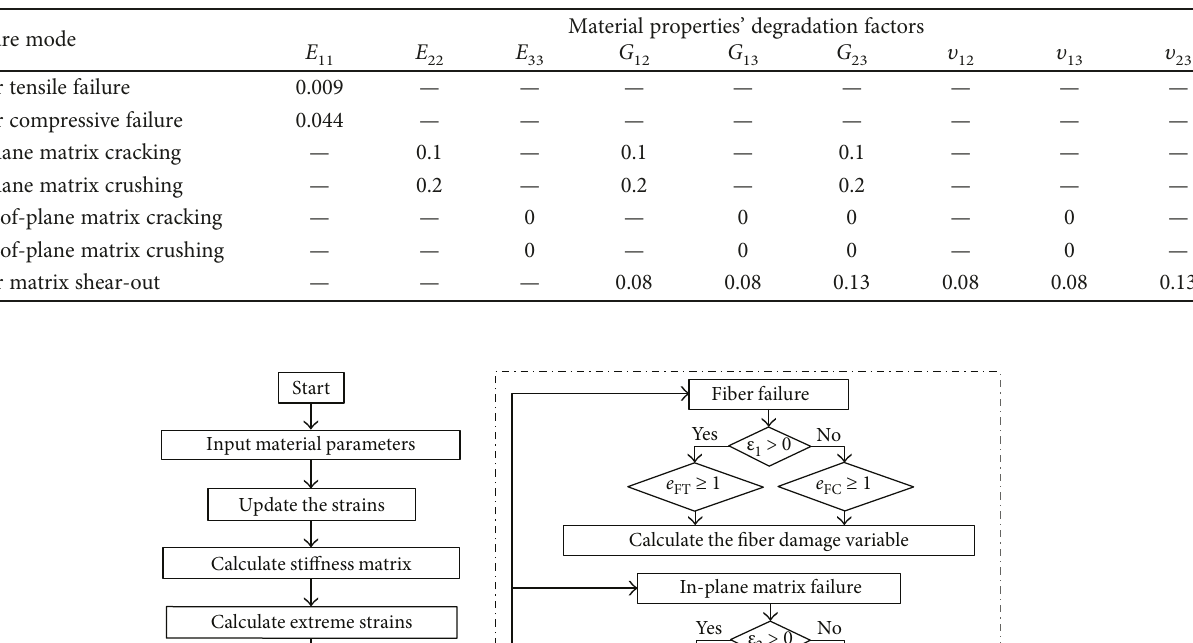
Table 4: Material degradation model